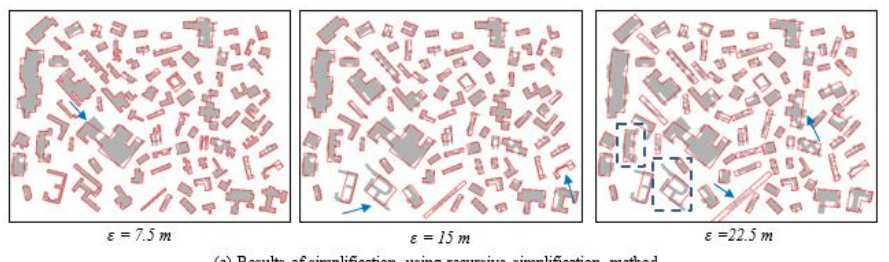
Figure 16. Results of the comparison test.